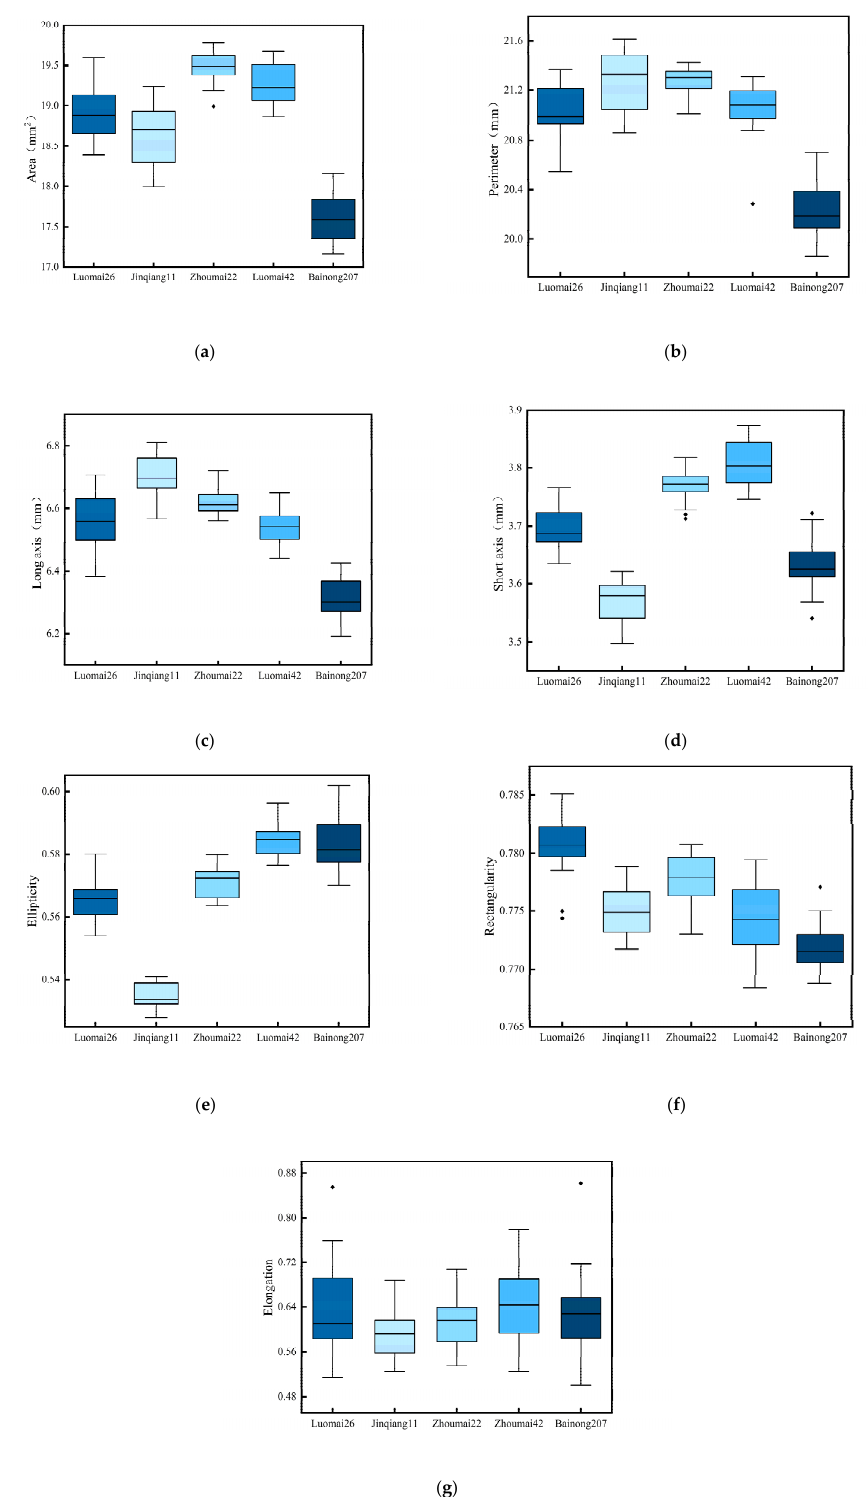
Figure 7. Distribution of seven phenotypic characteristic parameters of wheat seeds. The middle line of box is the median of the characteristic parameters and represents the average level of the charac- teristic parameters. The upper and lower limits of box are the upper quartile and the lower quartile of the characteristic parameters. Above and below the box, two lines represent the maximum and minimum values, respectively. ( a ) Area. ( b ) Perimeter. ( c ) Long axis. ( d ) Short axis. ( e ) Ellipticity. ( f ) Rectangularity. ( g ) Elongation.